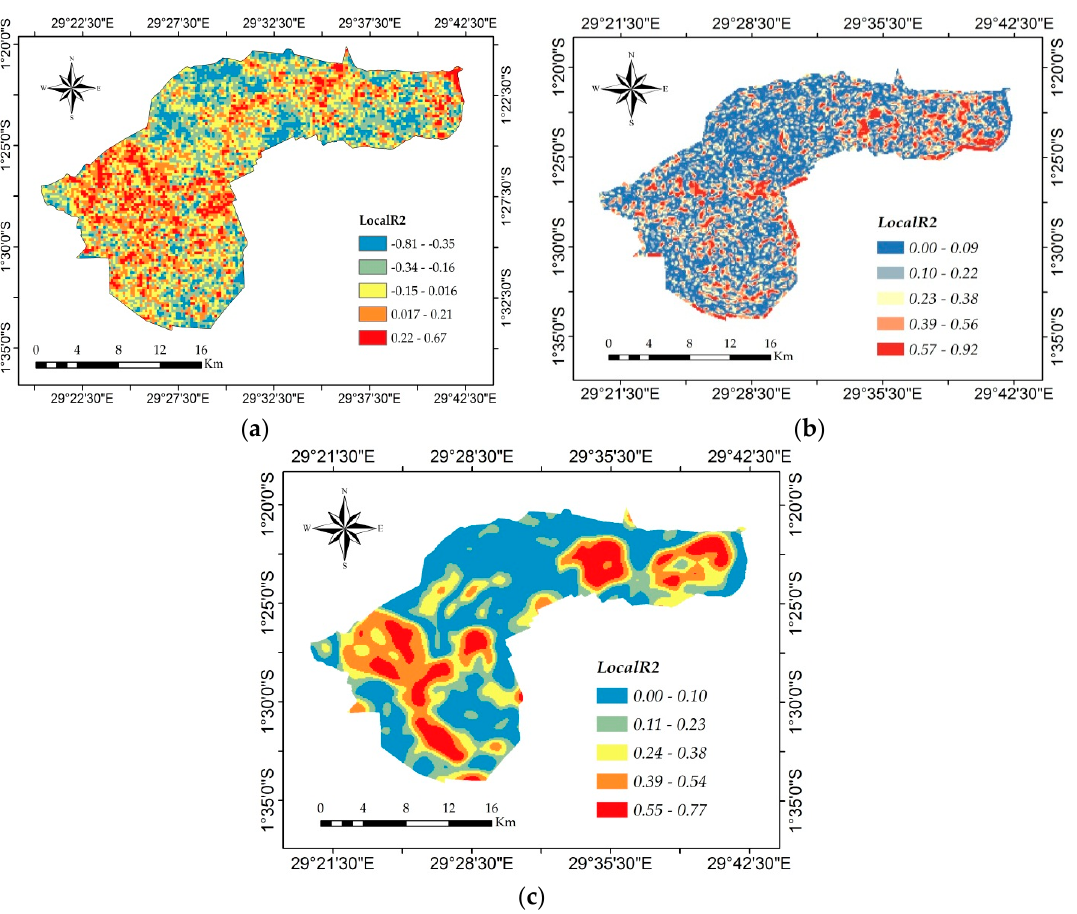
Figure 6. Spatial variability of the GWR model output, the coefficient of determination (Local R 2 ), results: ( a ) Relationship between NDVI and precipitation; ( b ) NDVI and LST; and ( c ) NDVI and ET.